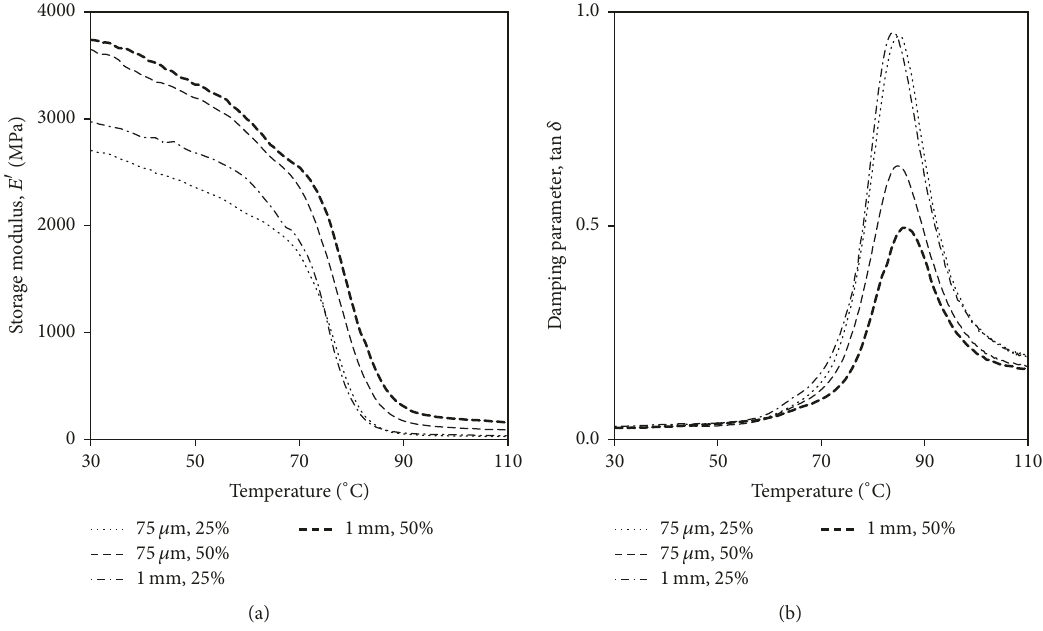
Figure 4: Typical DMTA plots of PVC/bamboo composites derived from C 2 : (a) storage modulus, 𝐸 󸀠 , and (b) tan 𝛿 .